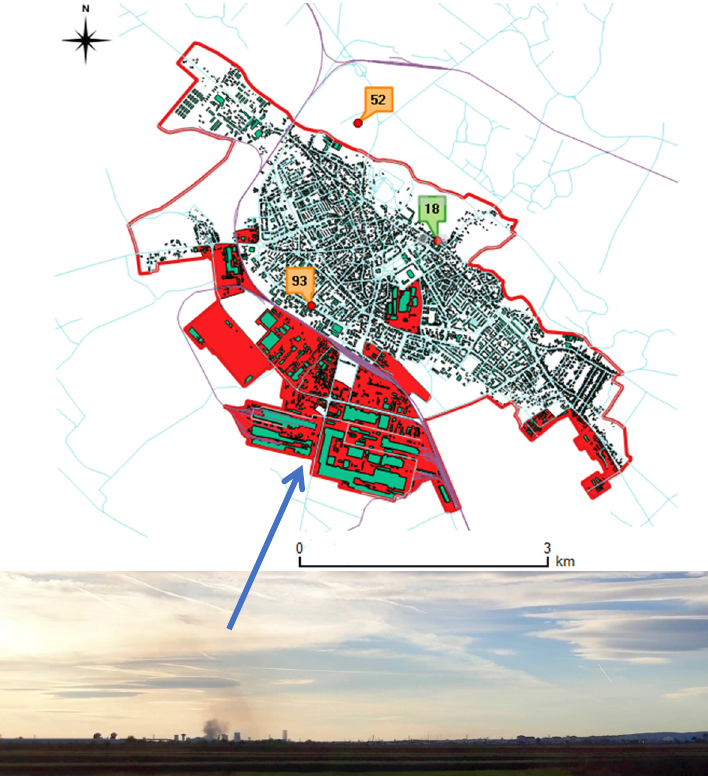
Figure 1. Study area showing the positions of rain samplers and automated PM monitoring stations in Targoviste city, Romania; arrow indicates the industrial area, and the associated picture depicts a pollution episode with suspended dust from the metallurgical processes recorded on 7 October 2019, 5.00 p.m., before the rainfall events (8 and 10 October); labels show the hourly PM 2.5 concentration ( μ g m − 3 ) recorded during the event; red areas—industrial zones.